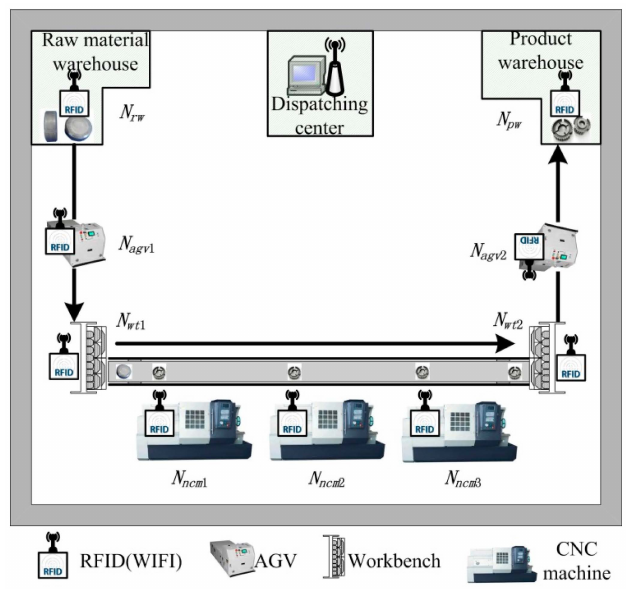
Figure 2. Sensing-aware environment of a wisdom manufacturing